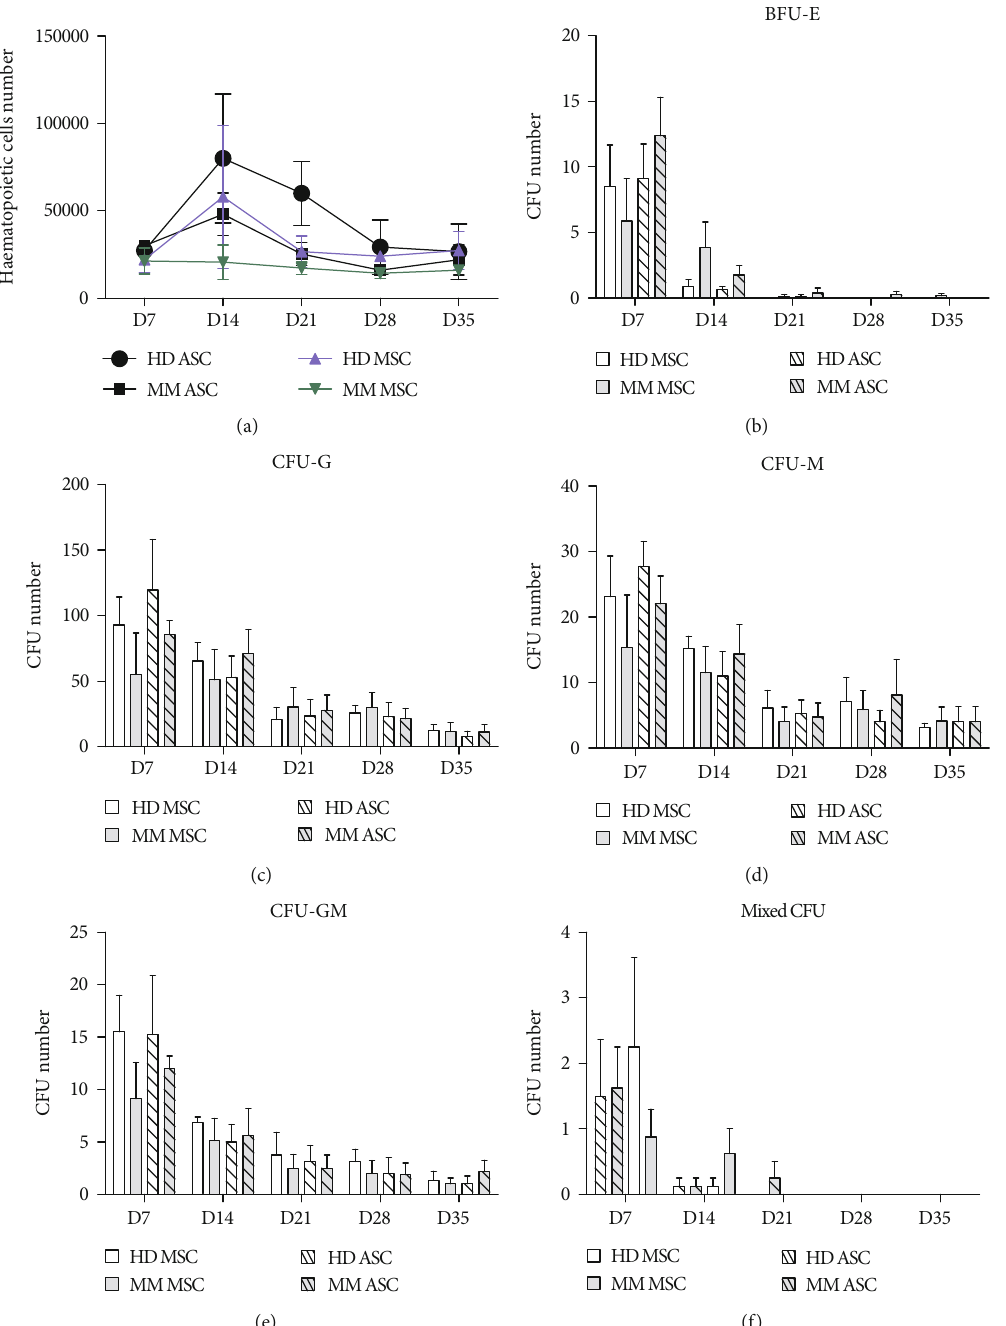
Figure 3: Hematopoiesis support potential of HD and MM ASCs compared with autologous MSCs. CD34+ hematopoietic stem cells were cocultured with HD/MM ASCs or MSCs. At days 7, 14, 21, 28, and 35, nonadherent hematopoietic cells were counted (a) and tested for hematopoietic progenitor content (b) burst forming unit (BFU)-erythroid (BFU-E), (c) colony forming unit (CFU)-granulocytes (CFU-G), (d) CFU-monocytes (CFU-M), (e) CFU-granulocyte macrophages (CFU-GM), and (f) mixed CFU. Data are the mean ± SEM number of CFU ( n = 4 independent